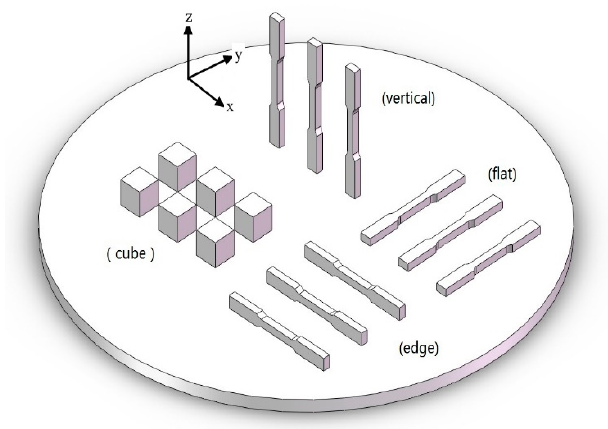
Figure 1. Computer-aided design (CAD) models of cubes and three orthogonal orientations (flat, edge and vertical) tensile samples on the stainless steel substrate.